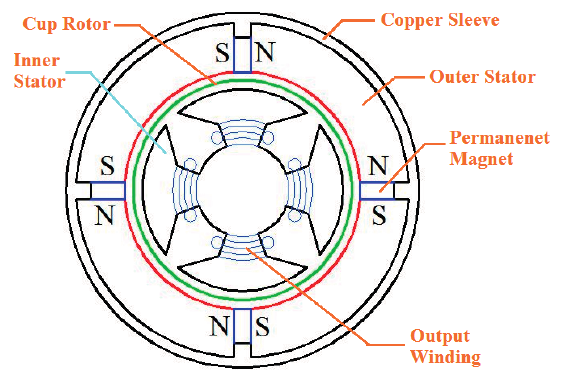
Figure 3. Cross-sectional sketch view of the sensor.